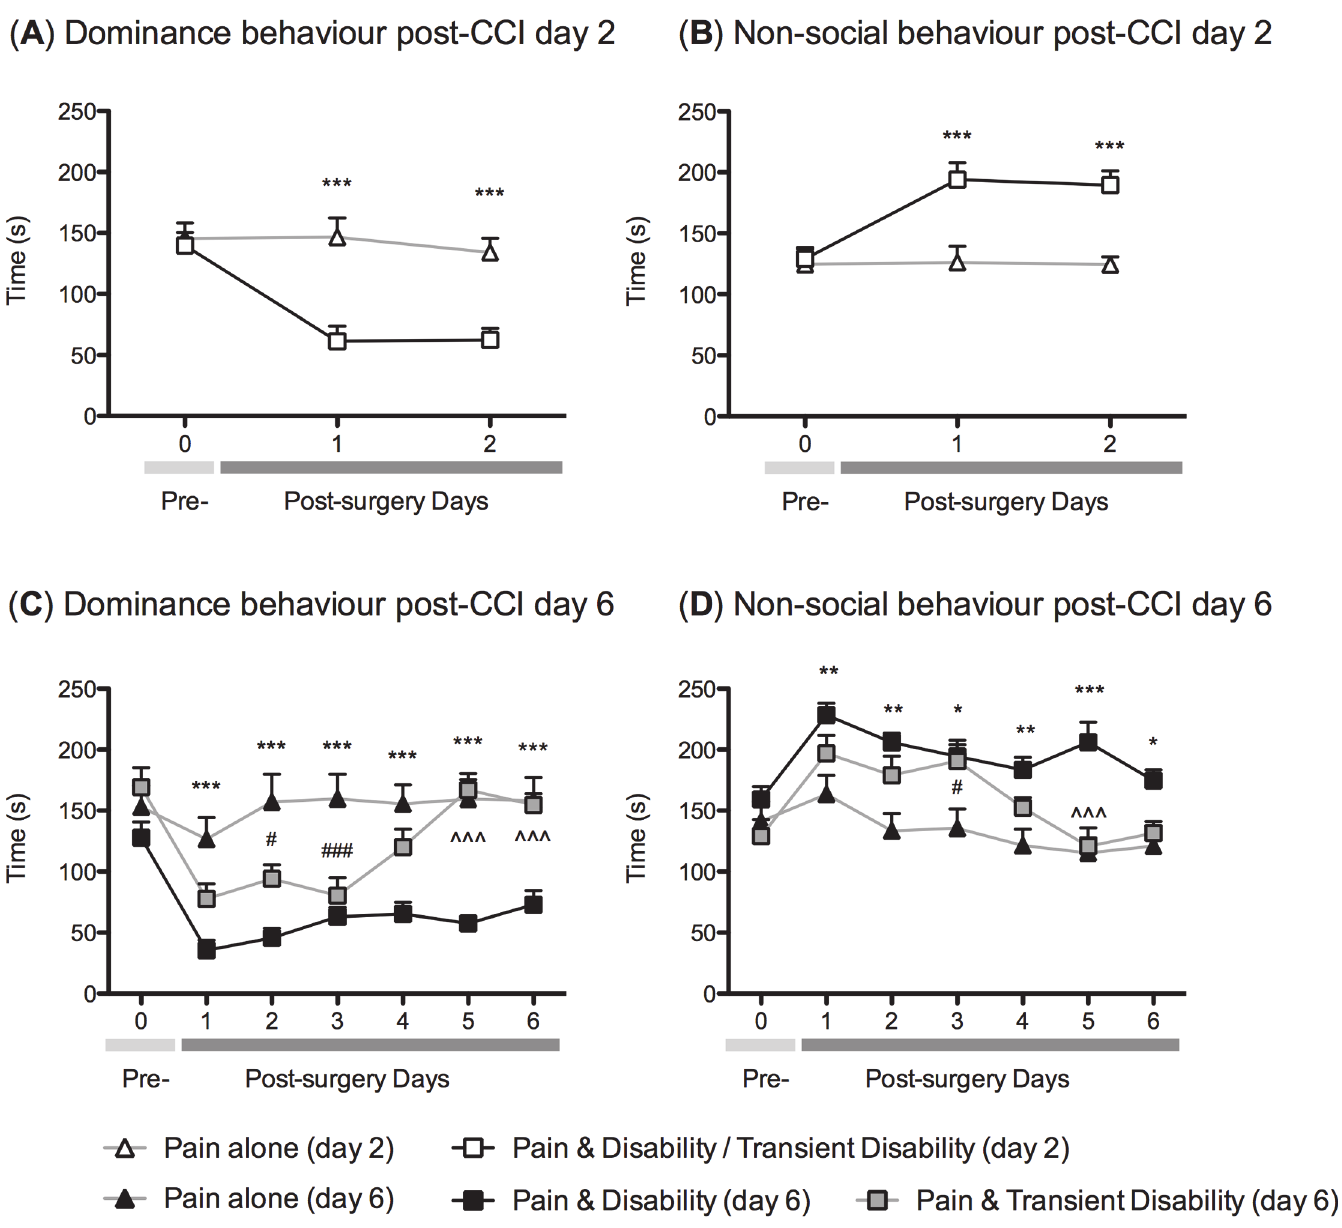
Fig 1. Resident-intruder social interactions testing following chronic constriction injury (CCI) of the sciatic nerve in disability categorised rats. (A&B) Line graphs showing mean ( ± s.e.m.) duration of dominance and non-social behaviours up to 2 days after CCI, for Pain & Disability (n = 9) and Pain alone (n = 9) rats. (C&D) Line graphs showing mean ( ± s.e.m.) duration of dominance and non-social behaviours up to 6 days after CCI, for Pain & Disability (n = 9), Pain & Transient Disability (n = 9) and Pain alone (n = 9) rats. These graphs show pooled behavioural data for all animals used in gene expression studies. Using a two-way ANOVA with a Bonferroni ’ s post-hoc test; * (P < 0.05), ** (P < 0.01) and *** (P < 0.001) indicate a significant difference between Pain & Disability and Pain alone rats, # (P < 0.05) and ### (P < 0.001) indicate a significant difference between Pain & Transient Disability and Pain alone rats, ^^^ (P < 0.001) indicates a significant difference between Pain & Disability and Pain & Transient Disability